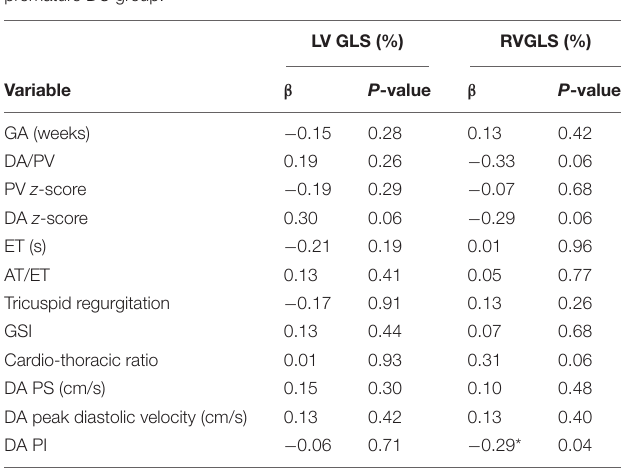
pulmonary artery pressure is inversely proportional to the AT/ET ratio, which indirectly illustrated that premature DA constriction would cause higher fetal pulmonary artery pressure, increased pulmonary vascular resistance, and increased afterload of the right heart (18, 19). Pulmonary artery stress increases pressure on the pulmonary valve, resulting in an increased z -score of the diameter of the pulmonary valve annulus. If it deteriorates, the result might be pulmonary valve annular enlargement and pulmonary valve regurgitation (2,